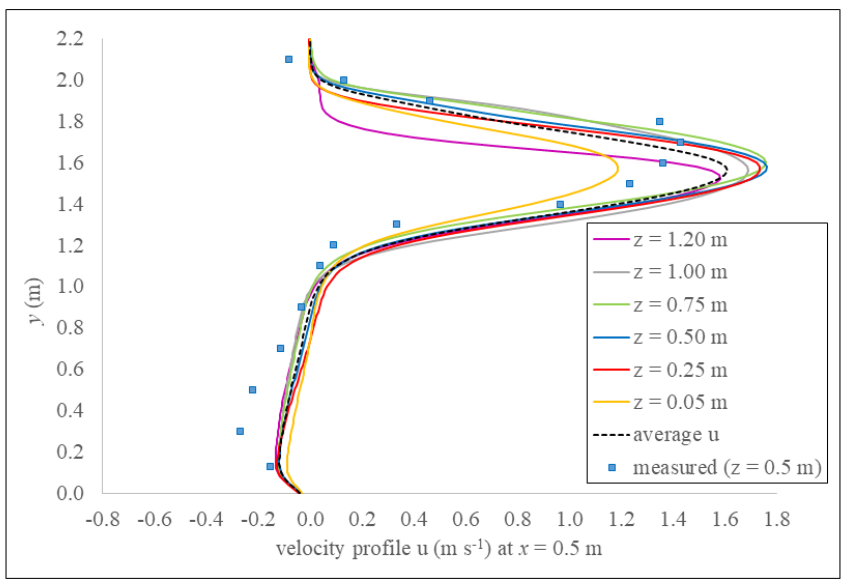
Figure 10. Calculated profiles of u at various depths z near the slot region.